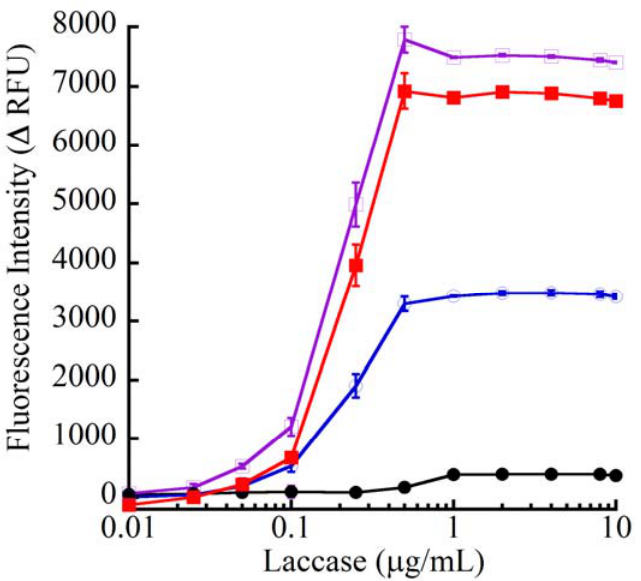
Figure 6. Laccase dose-response for CA oxidation. Increasing concentrations of laccase were used to oxidize 500  M CA for 60 min. Reactions were carried out in 96-well white plate (100  L/well) and stopped using 250 mM KOH (endpoint mode). Fluorescence was measured at 416 nm after exciting the samples using 290 nm (open squares, purple tracing), 310 nm (closed squares, red tracing), 340 nm (open circles, blue tracing) and 360 nm (closed circles, black